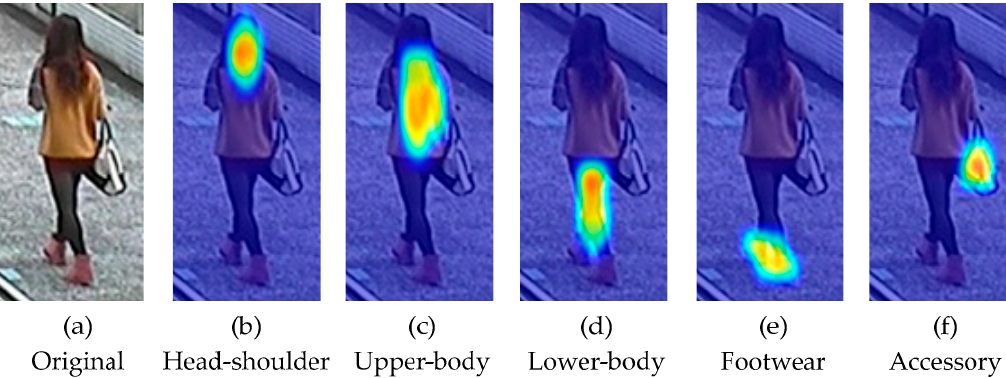
Figure 4. The attention heat map of the CNN-CAtt-ConvLSTM model when predicting pedestrian attributes in different regions. ( a ) is the original pedestrian image, ( b – f ) are the attention heat maps of the regions: head-shoulder, upper-body, lower-body, footwear and accessory.